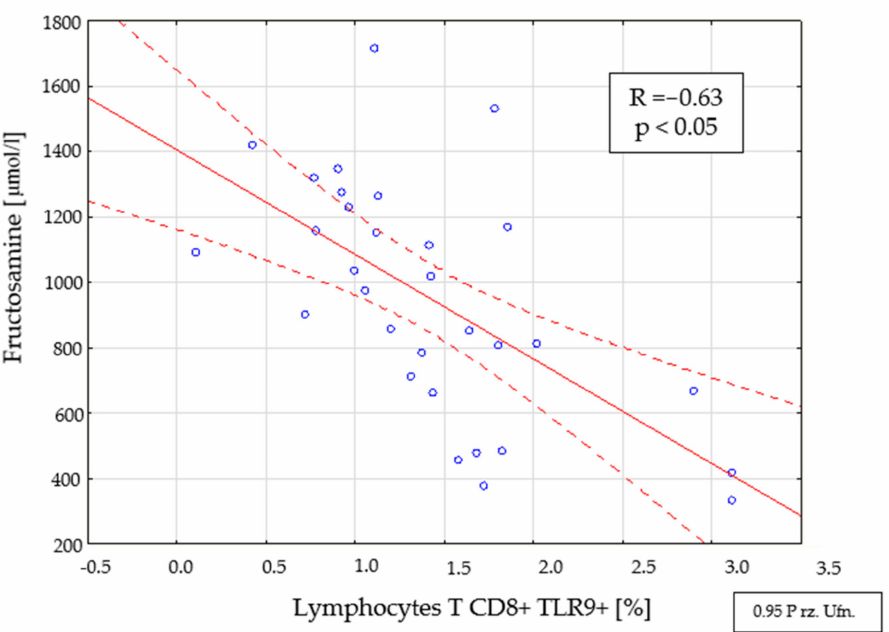
Figure 6. Relationship between the percentage of CD8+ TLR9+ T cells and the level of fructosamine in the group with newly diagnosed type 1 diabetes (<3 months from diagnosis). 2.5. Assessment of the Relationships between B CD19+, T CD4+, and T CD8+ Lymphocytes with TLR2, TLR4, TLR9 Expression, and Duration Time after the Onset of DM1 The performed analysis showed a correlation between CD19+ TLR9+ B cells (R = 0.3091, p < 0.05) and duration time after the onset of DM1 (Figure 7).